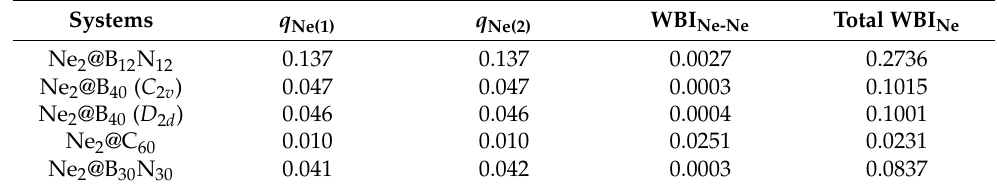
Table 3. Natural charges on the encapsulated Ne atoms, the WBI values between two Ne atoms, and the total WBI value of Ne